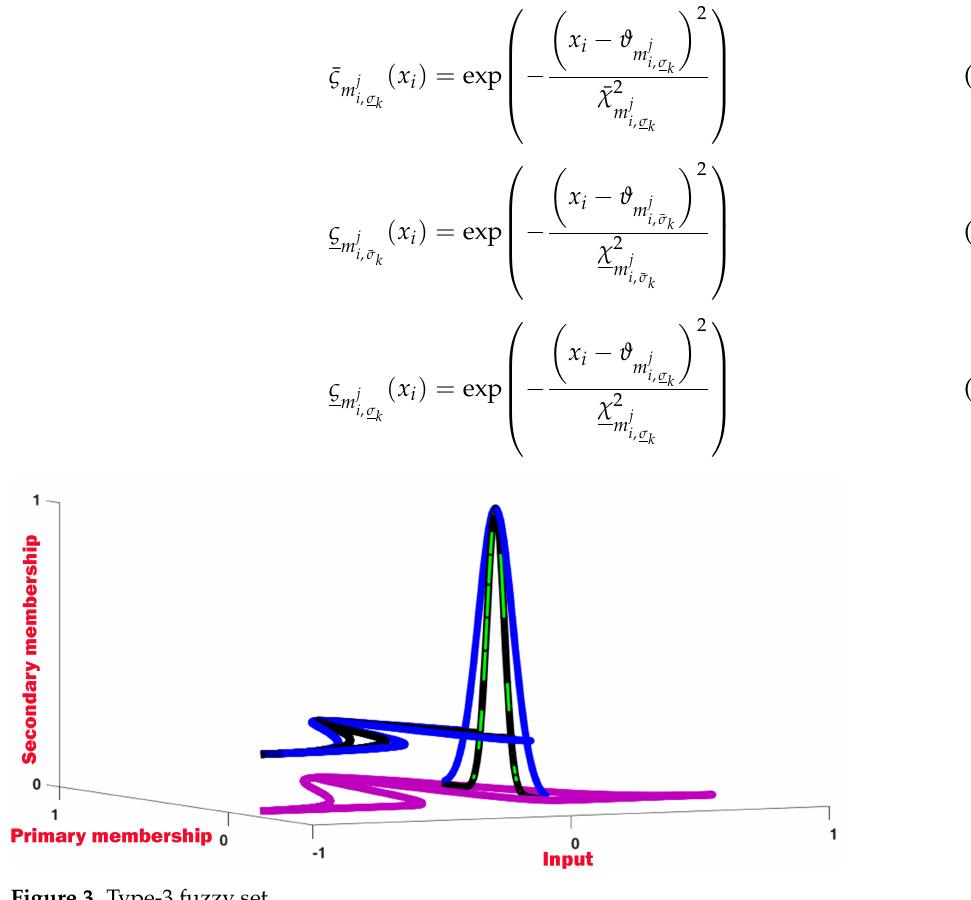
Figure 3. Type-3 fuzzy